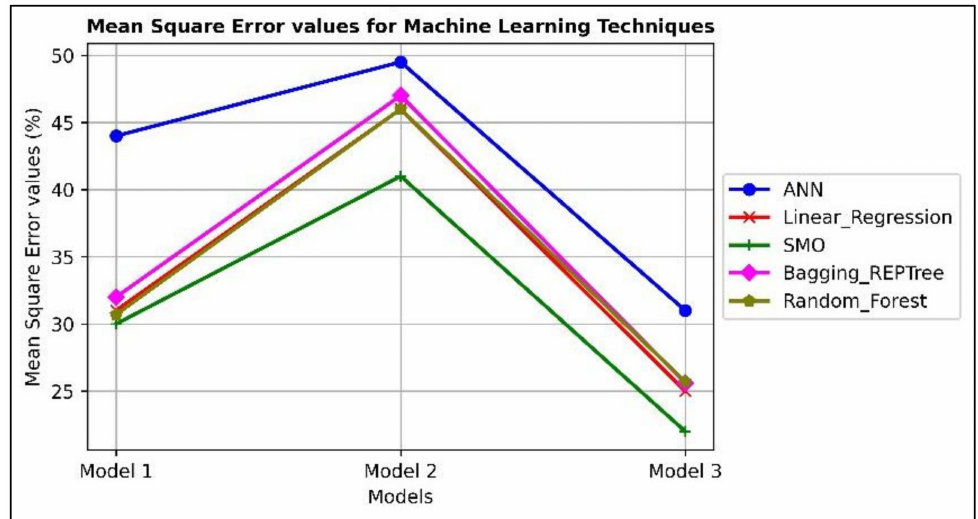
Figure 4. ML techniques mean square